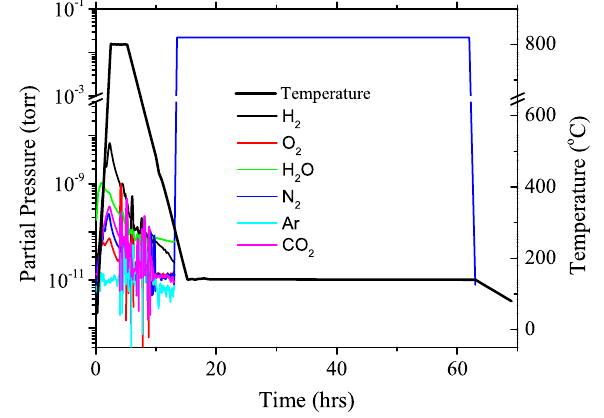
FIG. 1. Typical temperature and partial pressure of the gas measured during the heat treatment process. All partial pressures during the heat treatment were below 10 − 8 torr. The residual gas analyzer was turned off before N 2